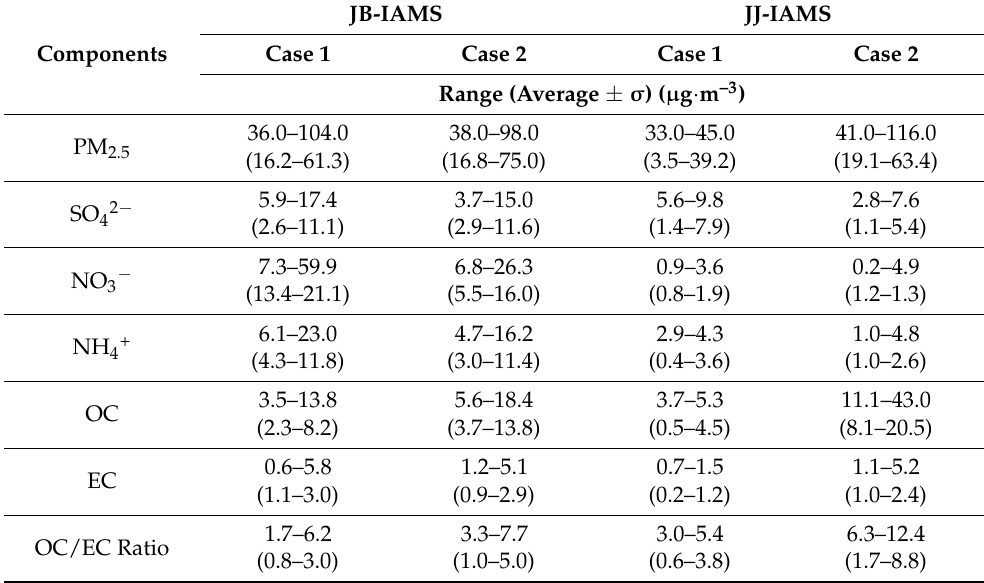
Table 3. Summary of PM 2.5 components SO 42 − , NO 3 − , NH 4+ , OC, EC, and the OC/EC ratio